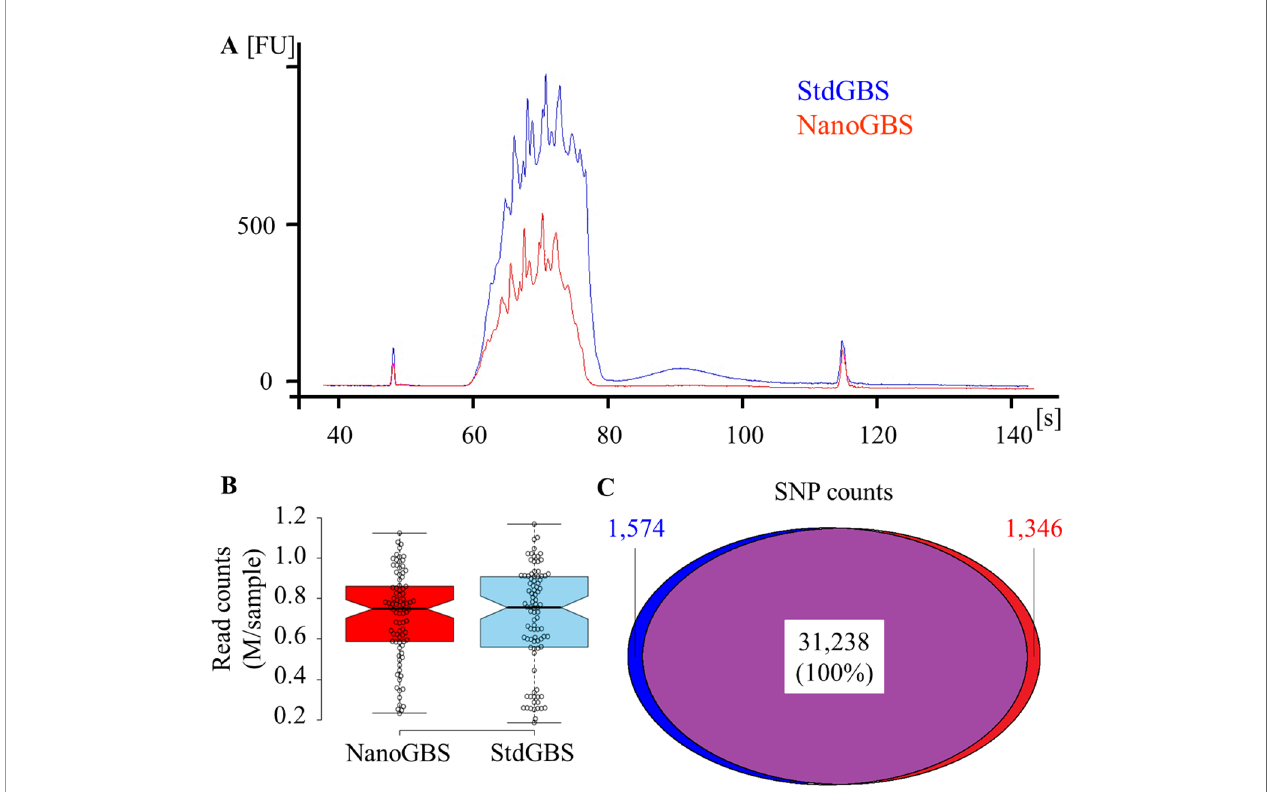
FIGURE 1 | Comparison of results obtained from standard genotyping-by-sequencing (StdGBS) vs. NanoGBS pooled libraries for a set 96 soybean samples. (A) Quality of DNA library pools using a Bioanalyzer. (B) Distribution of reads per sample after demultiplexing. (C) Number of SNPs and overlap between SNP catalogues derived from StdGBS vs. NanoGBS libraries. The level of agreement between SNPs called with these methods presented in